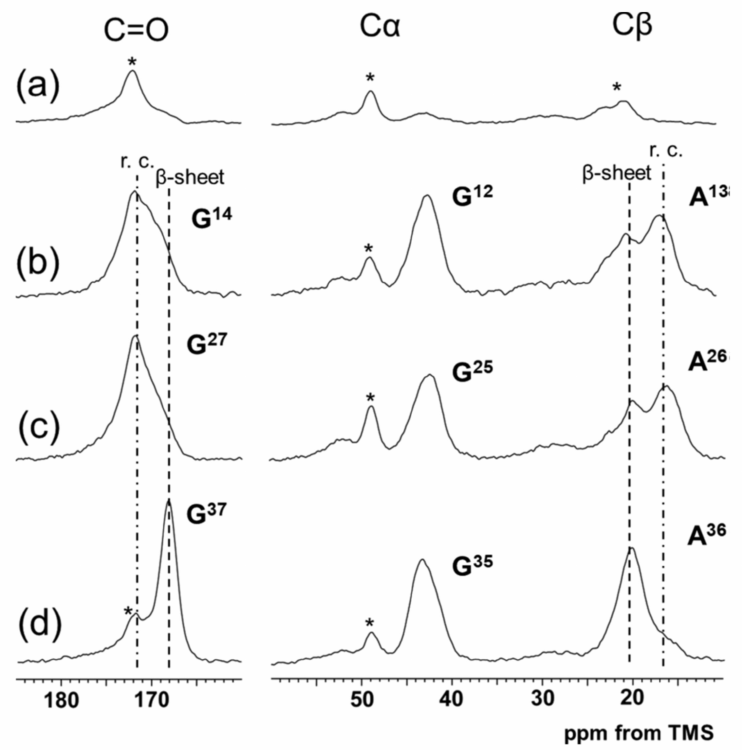
Figure 5. 13 C CP / MAS NMR spectra of 13 C successively triple-labeled 47-mer peptides incorporated as the [2- 13 C]Gly [3- 13 C]Ala[1- 13 C]Gly motif in di ff erent positions (Table 1